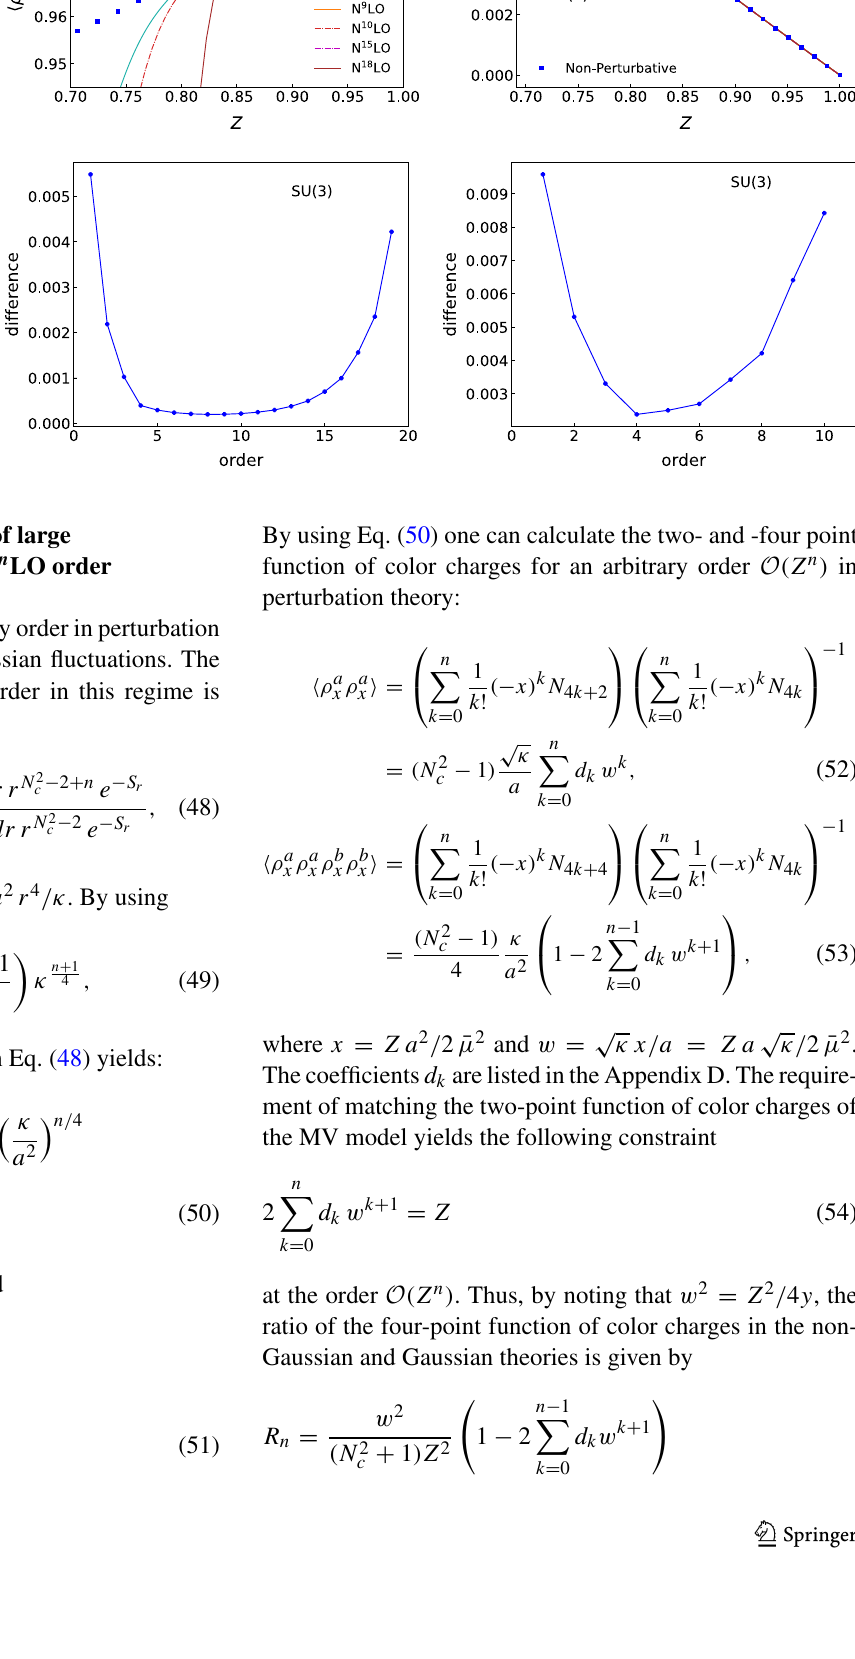
Fig. 3 Left panel: The ratio of the four-point function as a function of Z for SU(3). Right panel: The Z dependence of y = ¯ μ 4 /κ a 2 for different orders in perturbation theory. The full circles represent the result of the non-perturbative calculation